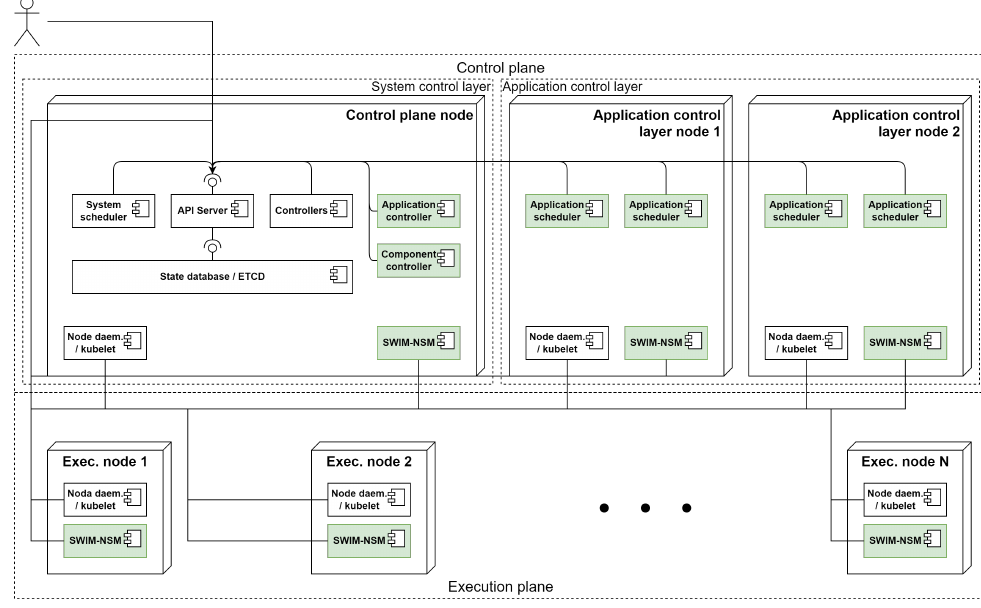
Figure 6. UML component diagram of ACOA architecture over